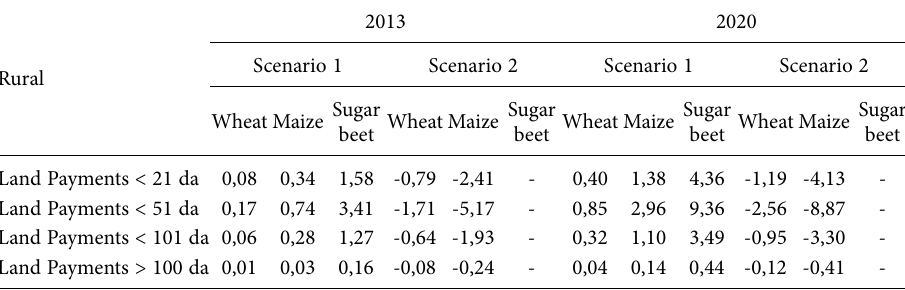
Table 5. Income effect sourced by agricultural lands-transfer effect (million TL)*.